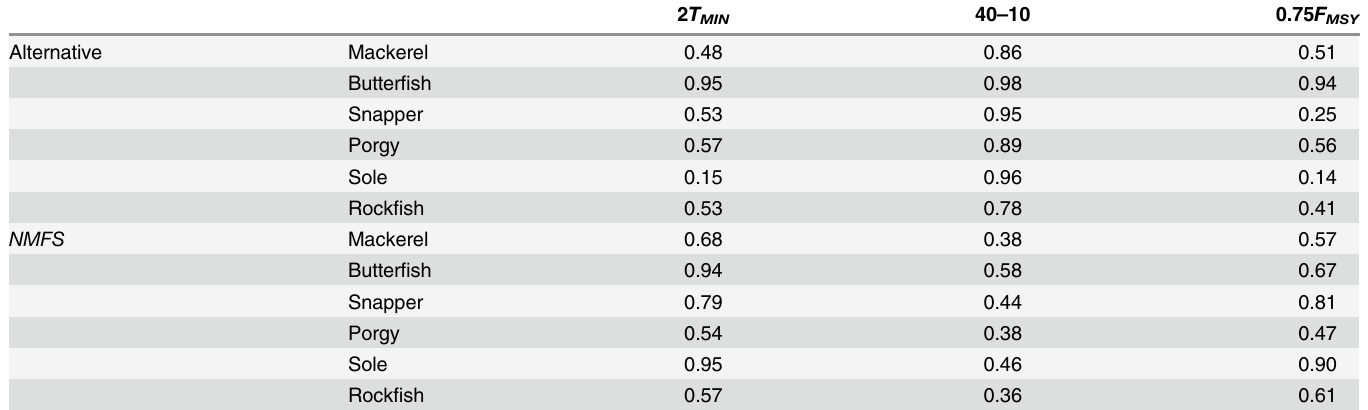
Table 1. Proportion of simulations in which (i) the three alternative MPs achieved as fast or faster rebuilding times than the NMFS MP (Perfor- mance indicator 1, top); and (ii) the NMFS MP achieved as fast or faster rebuilding times than the alternative MPs (Performance indicator 2, bottom) for the Baseline operating model